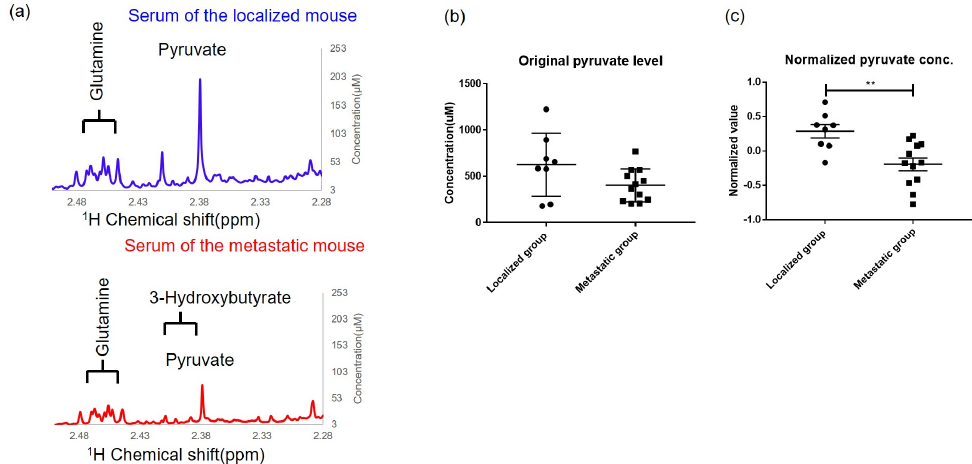
Table 1. The significantly different expression of various serum metabolites from the localized mice and metastatic mice were listed. Fold Change (Metastasis/Localized) p -Value Metabolites VIP Score >1.5 >1.2 or <0.8) Pyruvate 2.3382 0.65992 0.004294 ** O-phosphocholine 1.8351 1.4604 0.057379 Phenylalanine 1.7429 0.75095